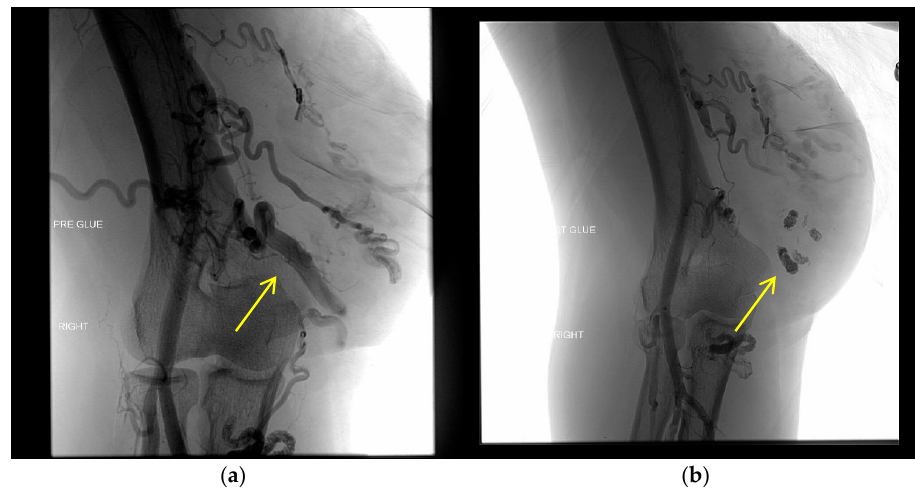
Figure 5. Embolization of an upper extremity AVM. Nidus formation (yellow arrows) with feeders from the brachial artery are occluded using the liquid embolic agent nBCA. The images show what appears to be a mixed AVM with proximal branches from the brachial artery and several large draining veins that eventually drain into the basilica vein, indicating a possible Yakes type IIa/IIb or Cho–Do type II/IIIa AVM. ( a ) Left image from a right brachial artery DSA shows the presence of the nidus pre-embolization. ( b ) Right image shows the occlusion of the nidus with nBCA, with added density using ethiodized oil, subtracted from this post-embolization DSA. Onyx and nBCA differ in their manner of deployment. Onyx can be injected into the site of the nidus without immediate precipitation, like nBCA, instead taking about 5 min to fully solidify [41].